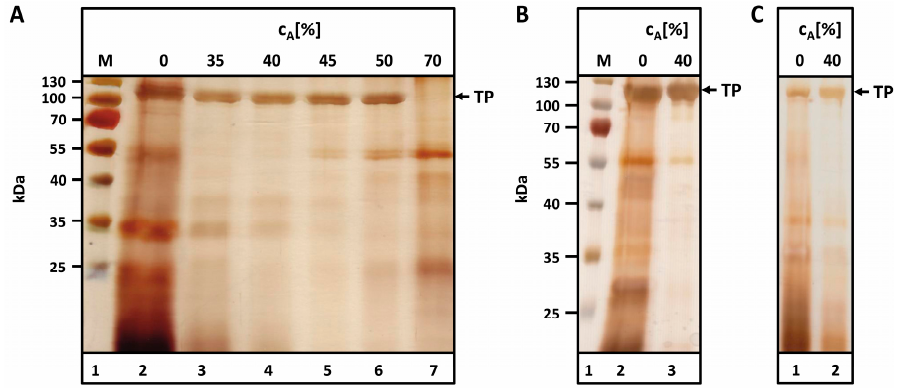
Figure 4. Purification of Q-MaSp1-100× ELP by fractionating acetone precipitation at: ( A ) small scale;